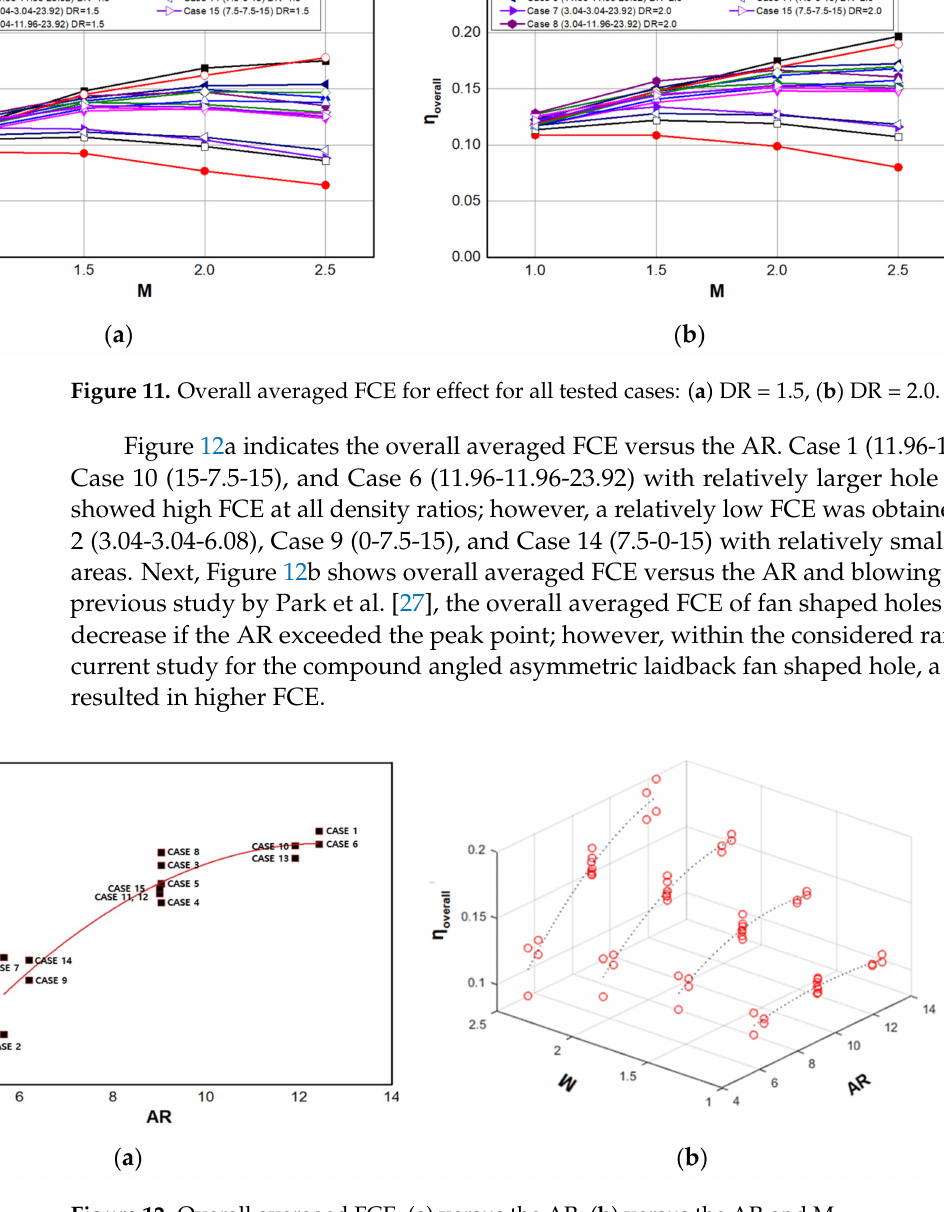
Figure 12. Overall averaged FCE: ( a ) versus the AR; ( b ) versus the AR and